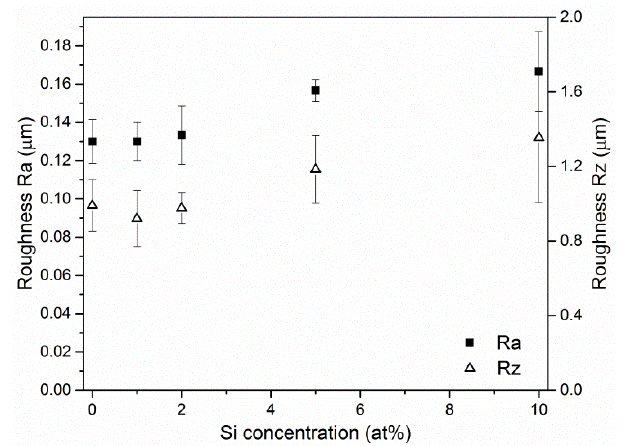
Figure 2. Roughness parameters of the AlCrSiN coatings formed from cathodes with silicon concentrations ranged from 0 at% to 10 at%.